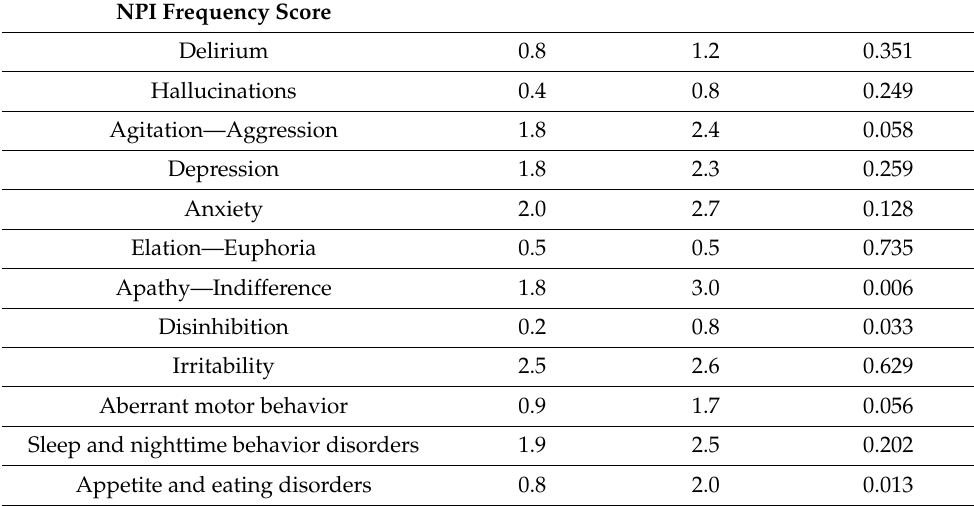
Table 4. Untreated patients: Evaluation of neuropsychiatric symptoms (T0–T1 six months).